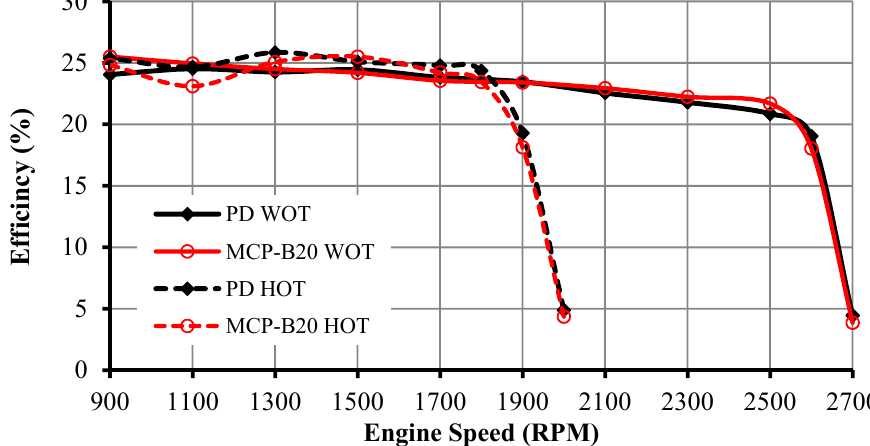
Figure 6. The relationship between tractor engine speeds (RPM) and engine efficiency (%) for PD and